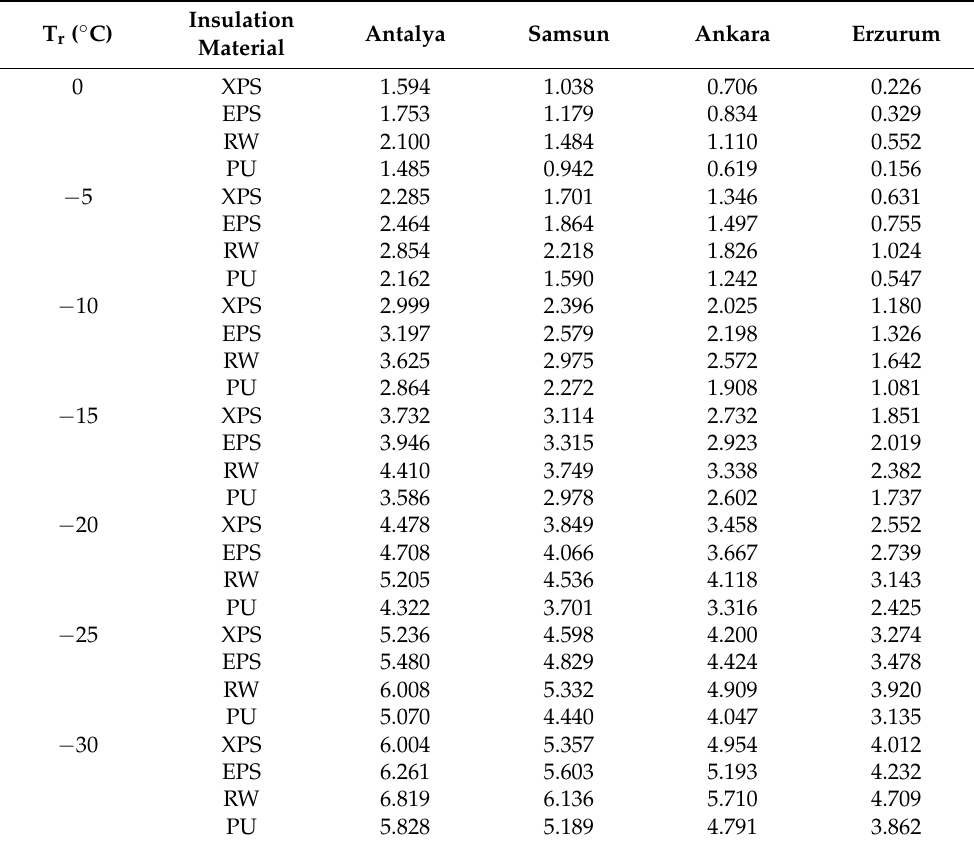
Figure 7. Annual energy saving results for PU, which would achieve optimum insulation thickness for the cold storage walls at 0 and −30 ° C in four locations in Türkiye. Table 5. Energy savings (USD/m 2 ) at different reference temperatures for four insulation materials in selected